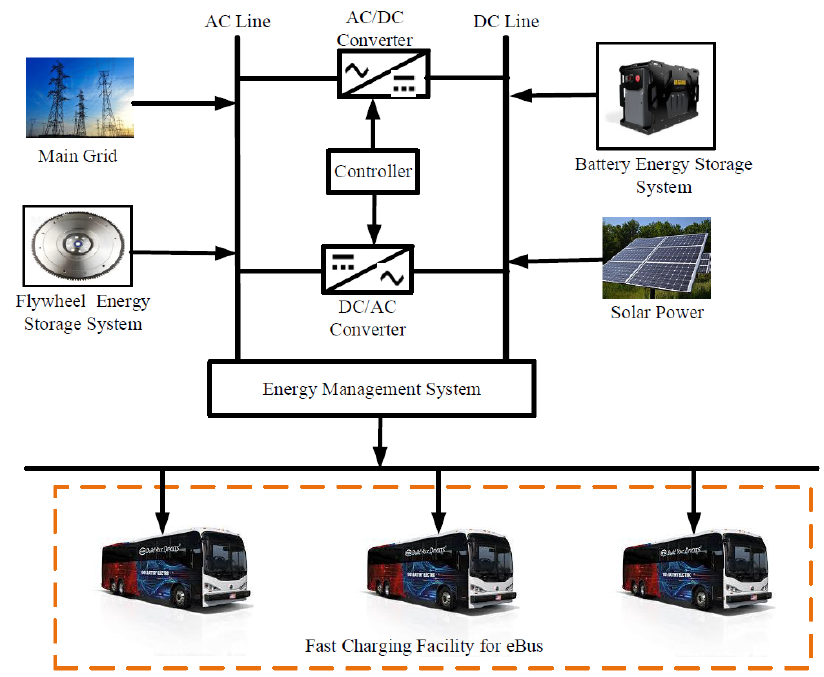
Figure 1. Proposed MEG based fast charging station with EMS for